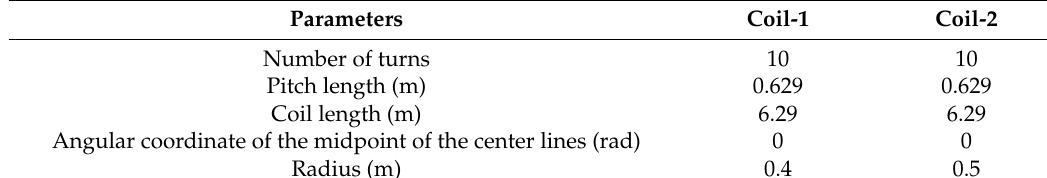
Table 7. Geometric parameters of the coils in Figure 3 (6th comparison).